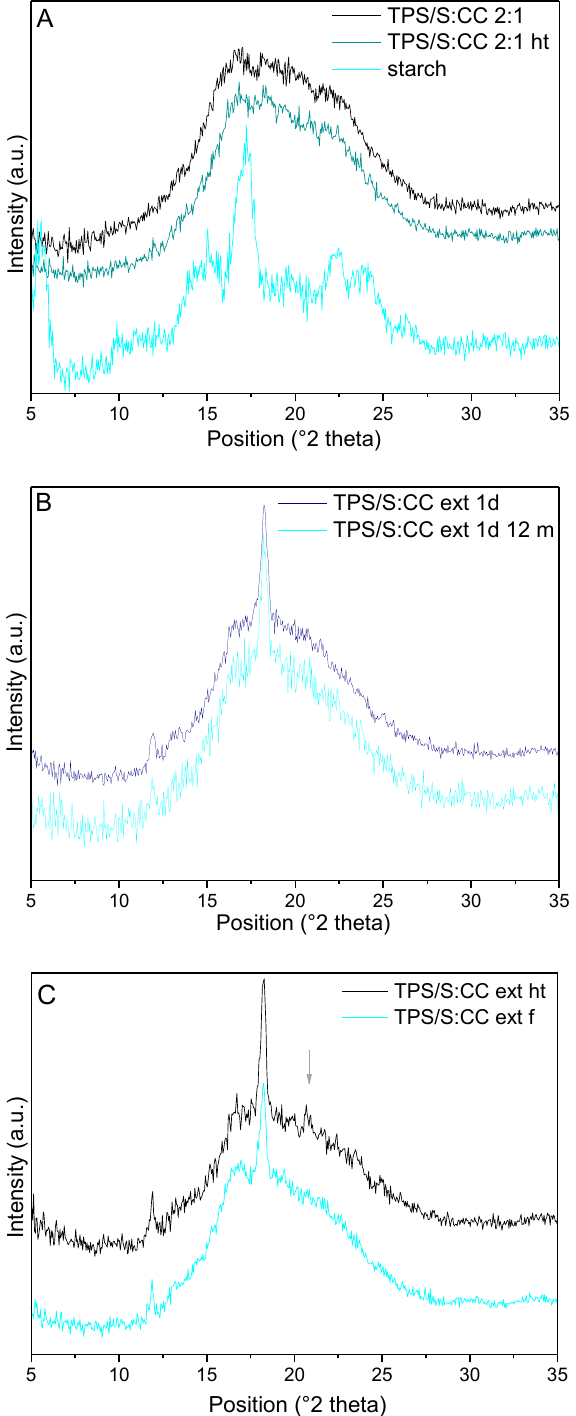
Figure4. XRDpatternsfor( A )nativePS(16.5wt%moisturecontent)andthermocompressedstarch / S:CC Figure 4. XRD patterns for ( A ) native PS (16.5 wt% moisture content) and thermocompressed 2:1 including additional preheating (ht); ( B ) films from extruded starch / S:CC 2:1 after 14 days (1d) of starch/S:CC 2:1 including additional preheating (ht); ( B ) films from extruded starch/S:CC 2:1 after 14 storage and after 1 year (1d 12 m)—both from premixture processed after 1 day of storage; ( C ) films from materials with di ff erent pretreatment